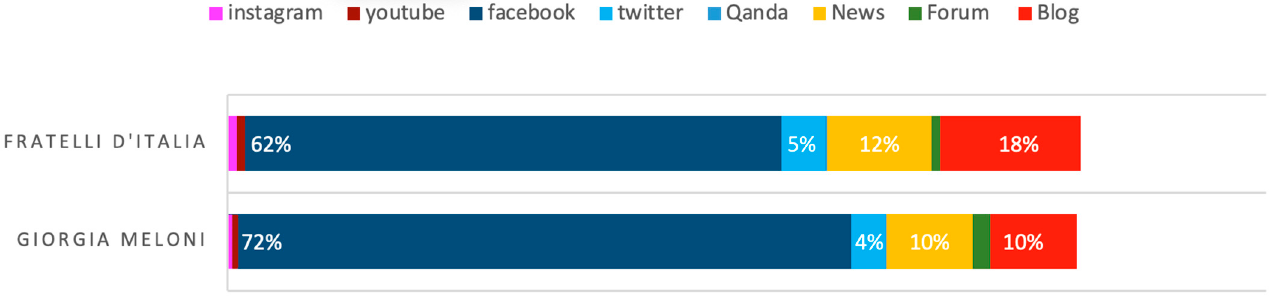
Figure 2. Automatic scanning by the tool FanPage Karma. Reference period: July 2020–June 2021.